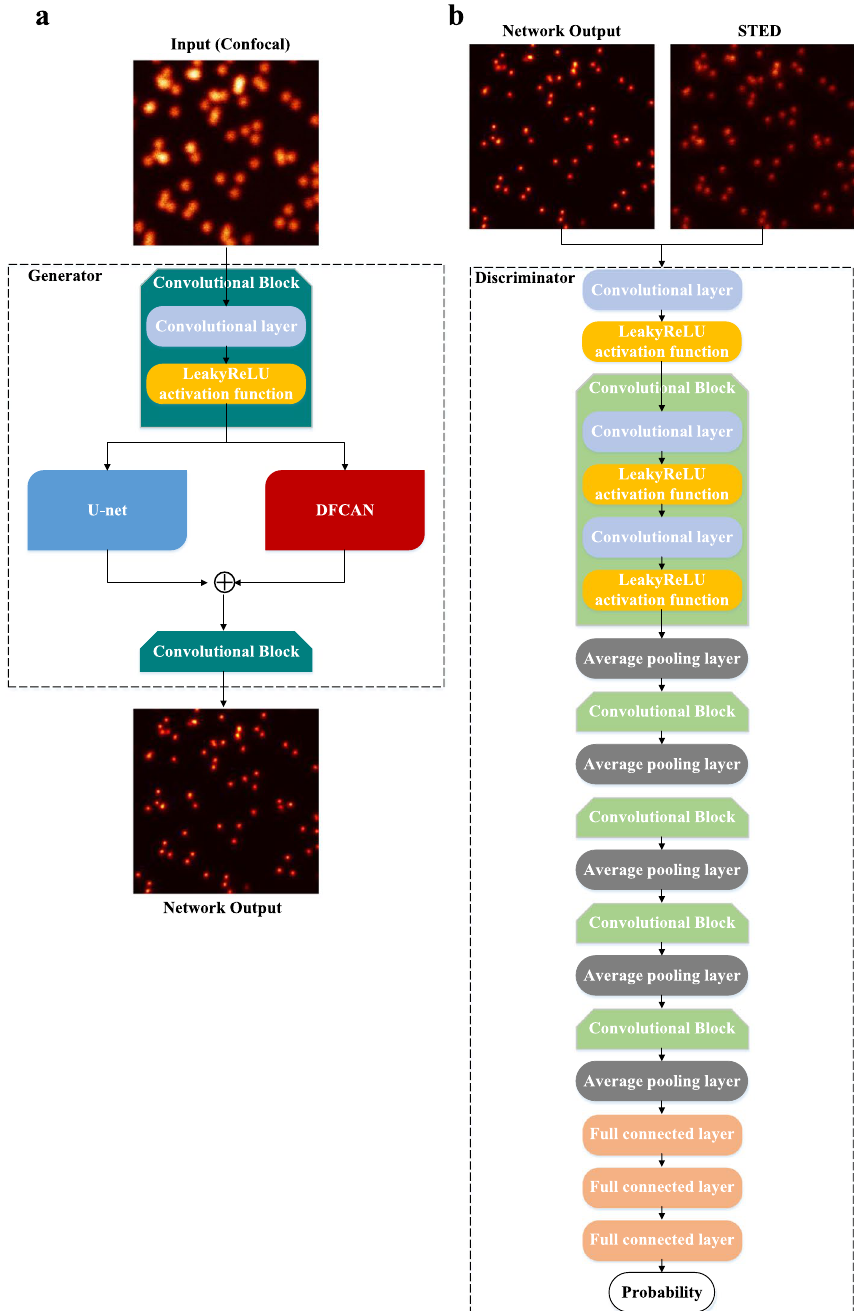
Fig. 1 The network architecture of TCAN. ( a ) The architecture of the generator of TCAN. ( b ) The architecture of the discriminator of